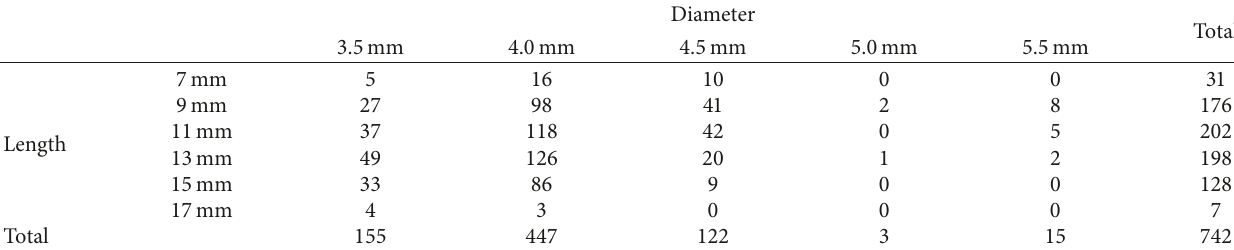
Table 2: Implant lengths and diameters.